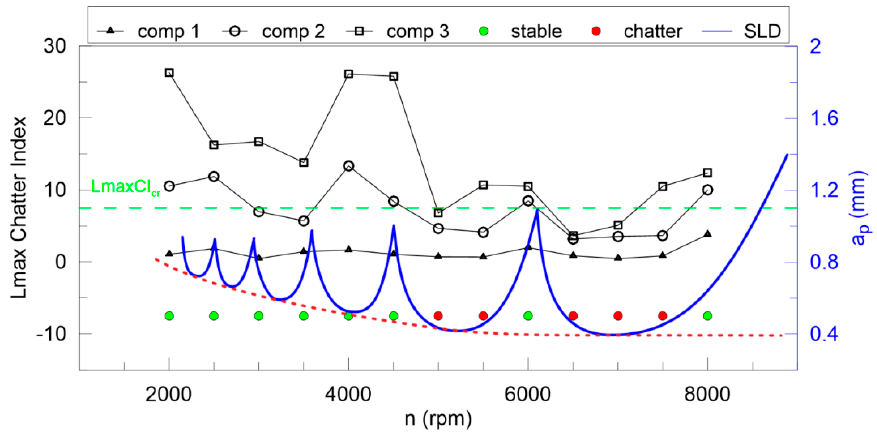
Figure 14. The L max chatter index (left axis) and the hypothetical stability lobe diagram (right axis) versus cutting velocity.